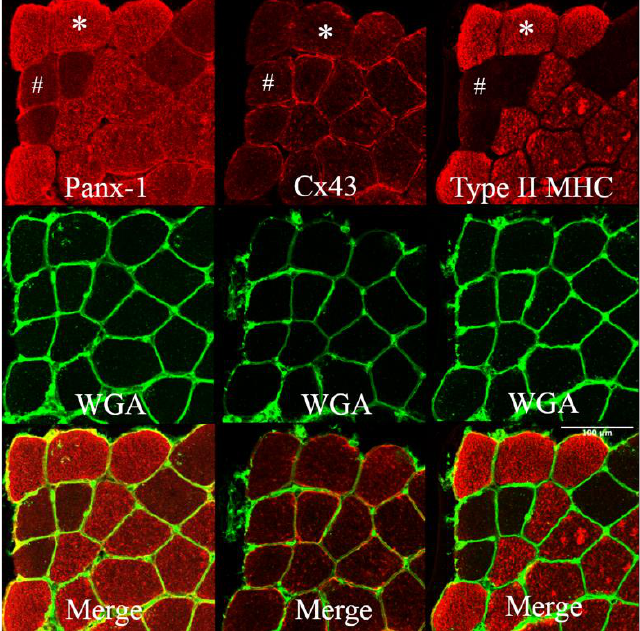
Figure 1. Panels showing Panx-1 and Cx43 immunostaining on human vastus lateralis biopsies at baseline. WGA lectin detects N-acetylglucosamine and N-acetylneuraminic acid (sialic acid) residues, resulting in the staining of the sarcolemma. Staining was obtained on serial cryosections. The staining of Panx-1 appears to significantly overlap with the Type II (IIA + IIX) MHC profile, and the intracellular staining is more prominent in fast muscle fibres. The same fast myofiber is indicated by an asterisk (*) showing Panx-1 intracellular staining. The hashtag (#) indicates the same Type I myofiber with poor Panx-1 intracellular but evident sarcolemma staining. Cx43 shows fainter staining, essentially at the membrane level without fibre-type specificity. Confocal microscope Leica SP5; 20 ×